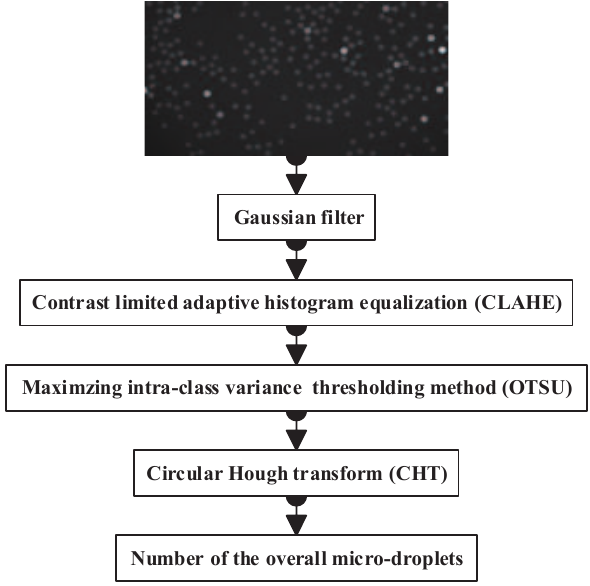
Figure 1. The framework of the proposed method for the overall micro-droplet detection.